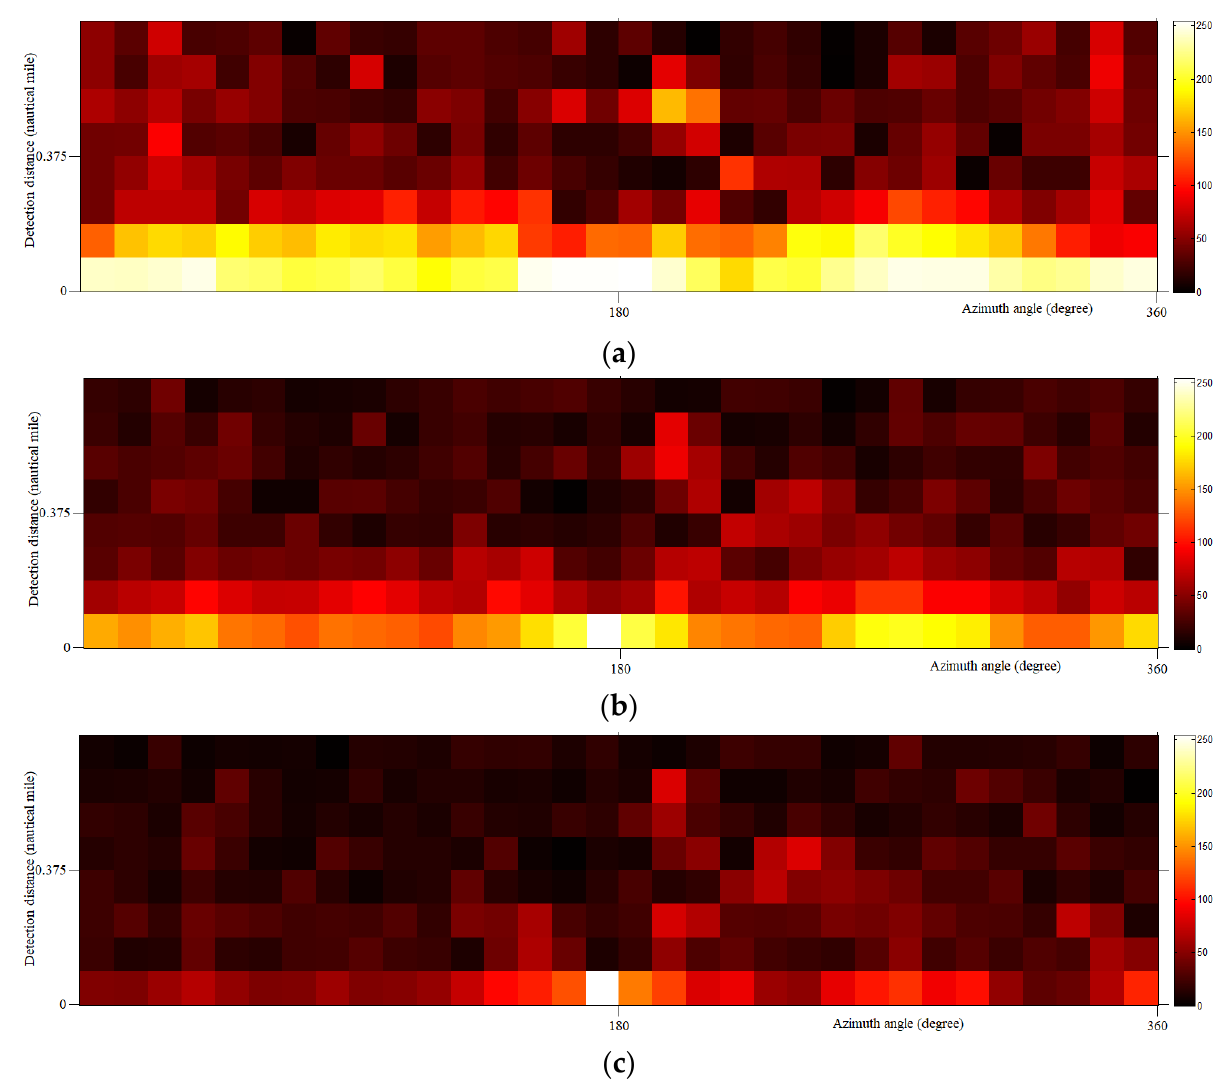
Figure 13. Different GLCM feature maps of preprocessed image. ( a ) Correlation; ( b ) Homogeneity; ( c ) Energy.